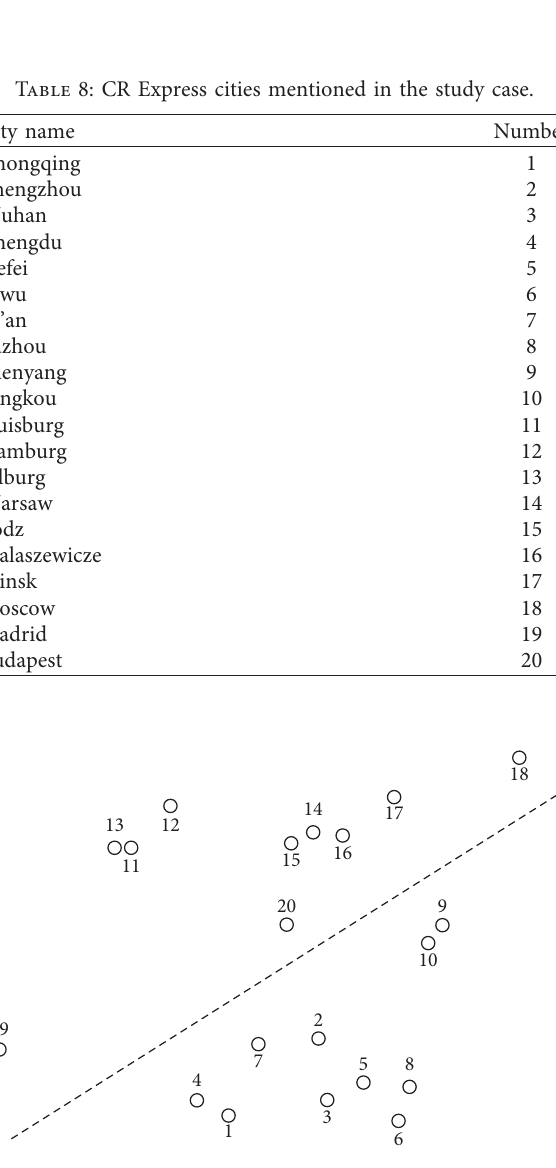
Figure 6: Relative location map of major CR Express cities. It shows the positional relationship of cities studied in the instance by abstracting the real geography map.